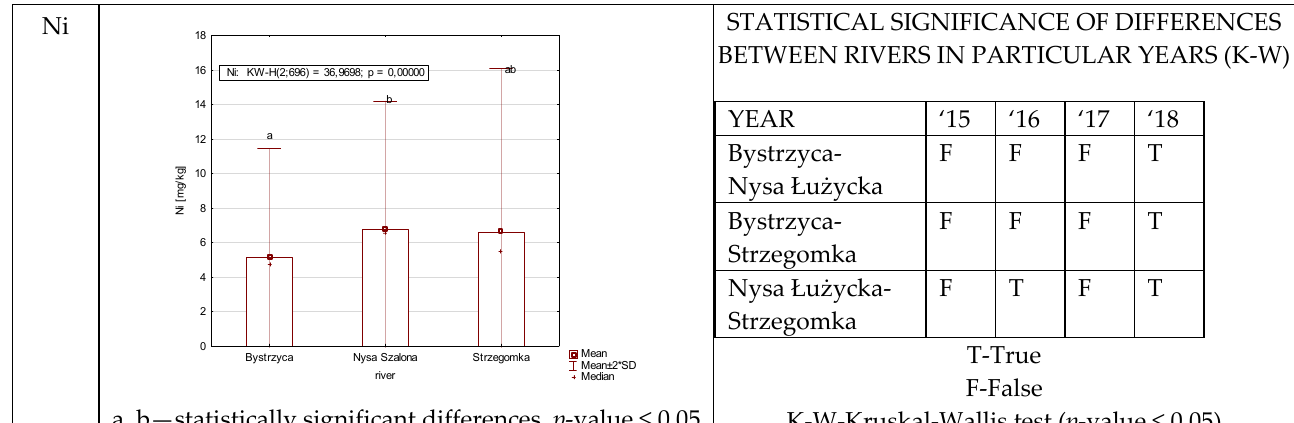
Lead levels in plants ranged from 1.63 mgPb ∙ kg − 1 to 87.36 mgPb ∙ kg − 1 , with averages oscillating between 8.74 mgPb ∙ kg − 1 and 22.26 mgPb ∙ kg − 1 (Table 5). Bioaccumulation with